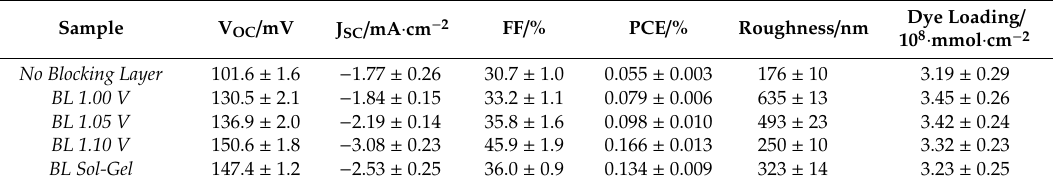
Table 2. Photoelectrochemical figures of merit of NiO-based DSSCs with or without the implementation of a blocking layer.